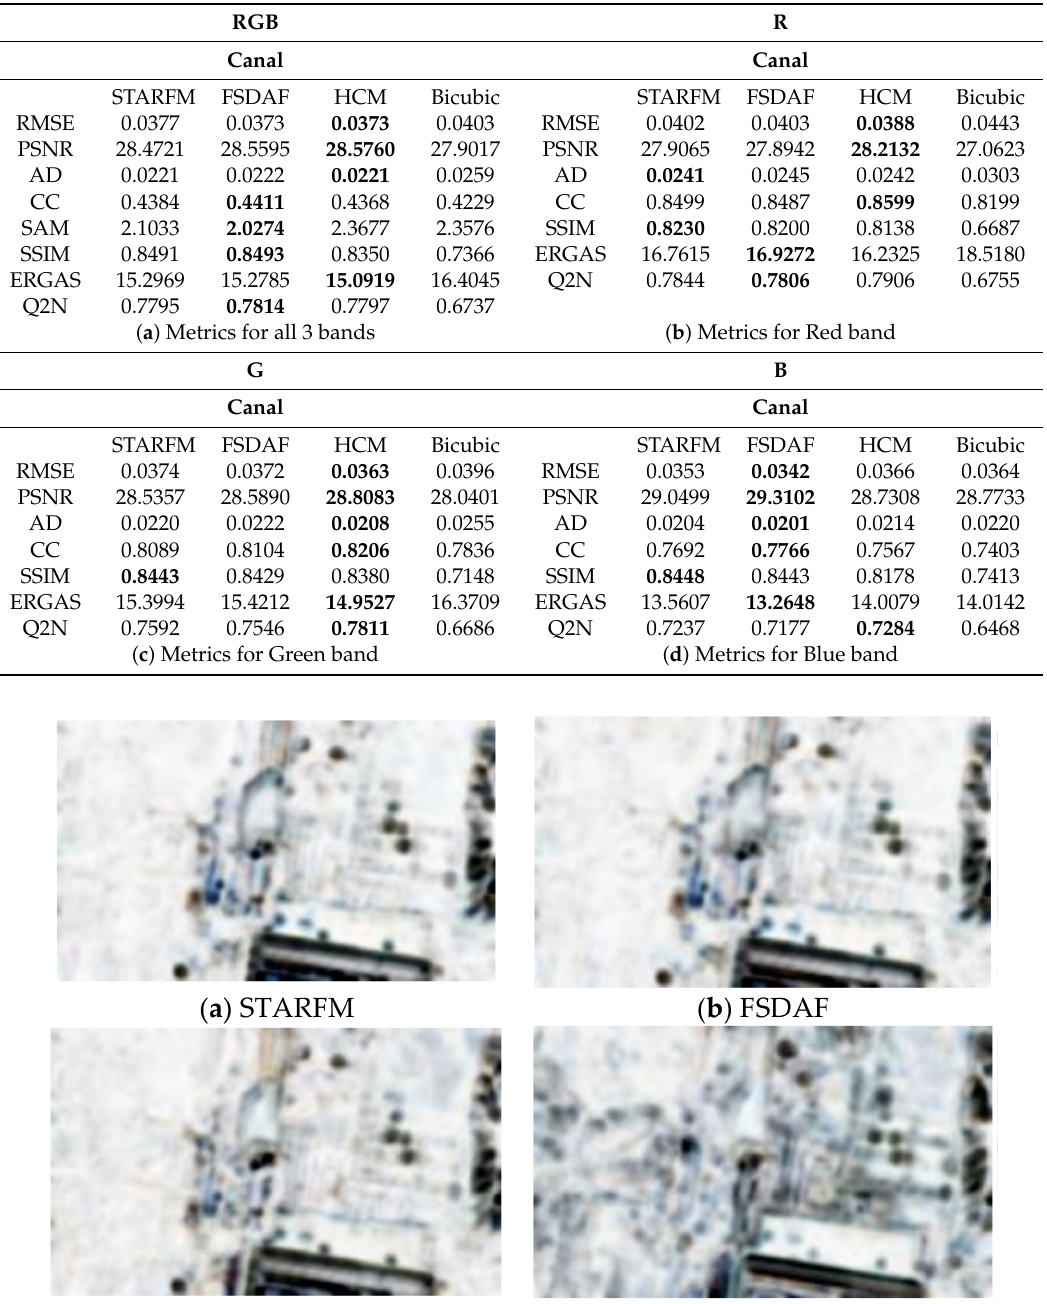
Table 5. Comparison of prediction results of using Planet and WV images for the scenario depicted in Figure 5. Bold characters indicate the best performing method for that row.